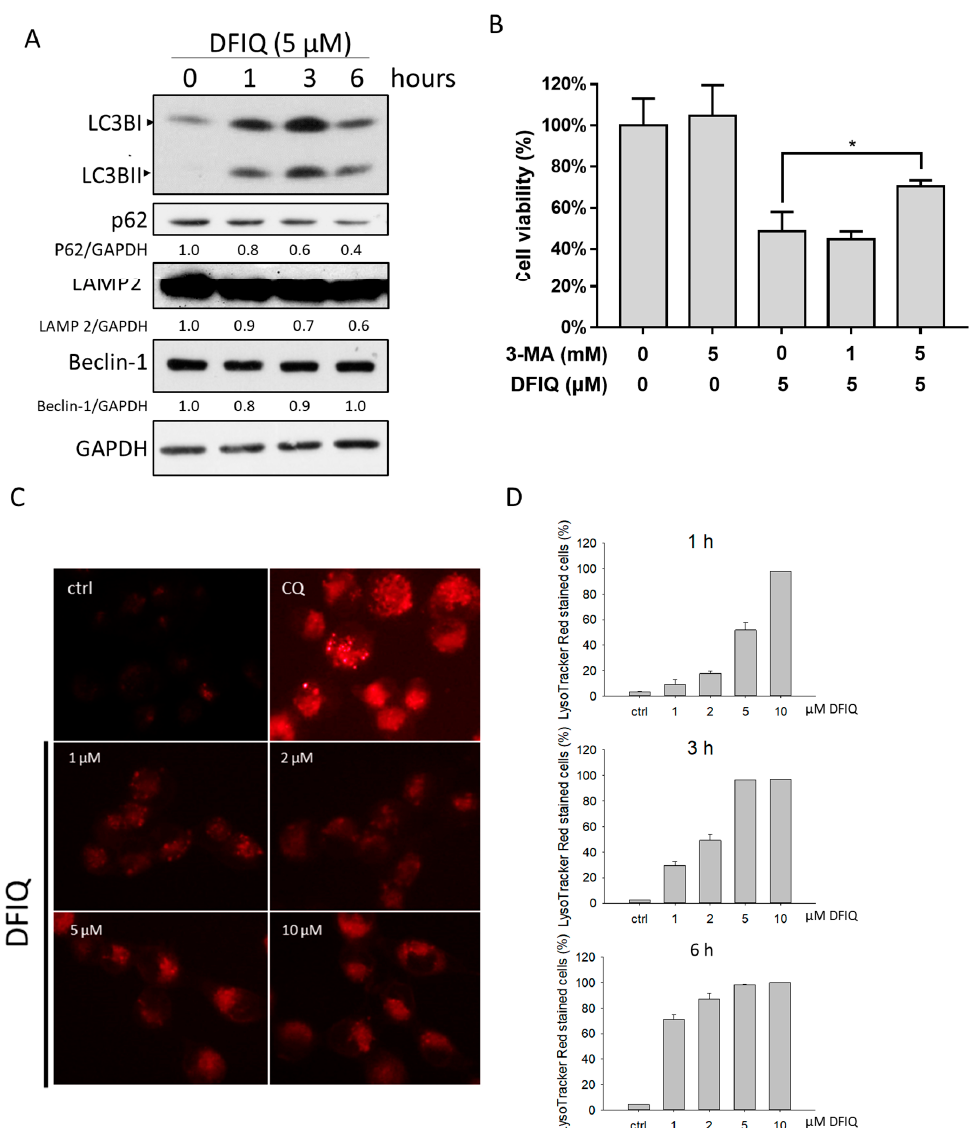
Figure 4. Autophagy might be involved in DFIQ-mediated apoptosis. ( A ) Western blot analysis of autophagy-associated proteins after the indicated DFIQ treatment. ( B ) H1299 cells were pretreated with the autophagy inhibitor 3-methyladenine (3-MA) before treatment with DFIQ, and viability was monitored. ( C ) Lysosomes were stained with LysoTracker Red to observe lysosome formation after DFIQ treatment for 6 h. Chloroquine (CQ) served as a positive control. ( D ) Quantification of lysosome formation at di ff erent time points of DFIQ treatment. * p < 0.05 compared with the control group. The uncropped blots and molecular weight markers of Figure 4A are shown in Figure